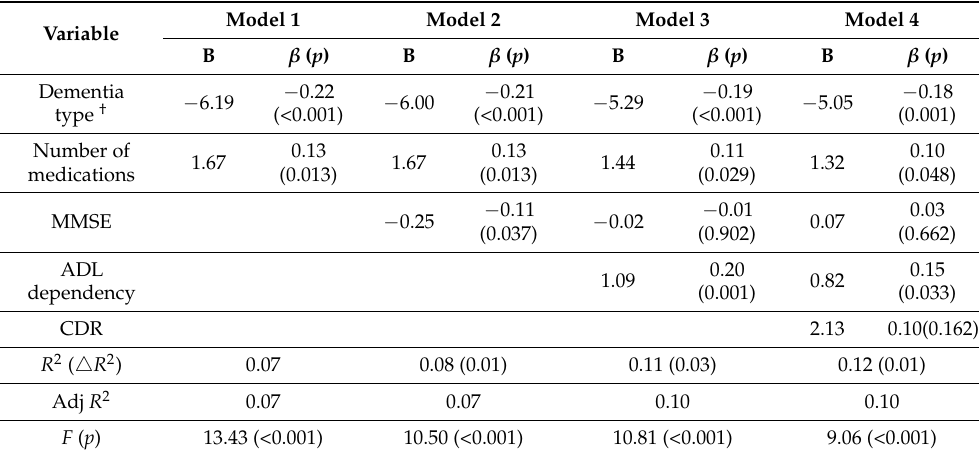
Table 3. Predictors of BPSD in Community-dwelling Persons at the First Time of Dementia Diagnosis ( n =